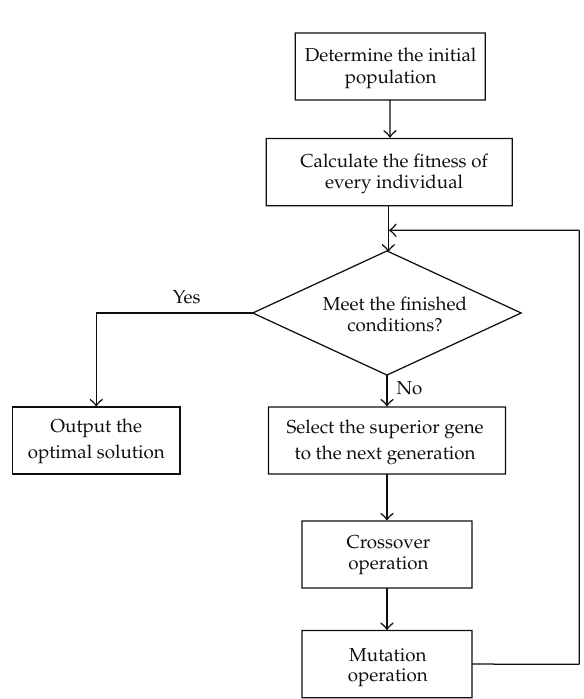
Figure 2: Genetic algorithm flow diagram.